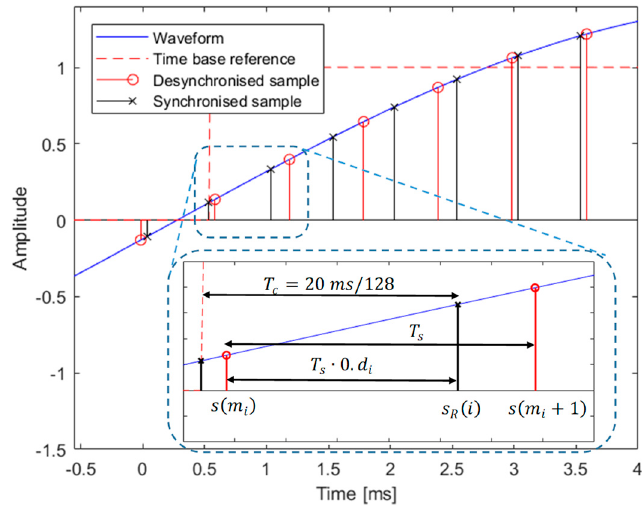
Figure 9. Resampling of voltage signal, real sample are interpolated in desired instants of time.